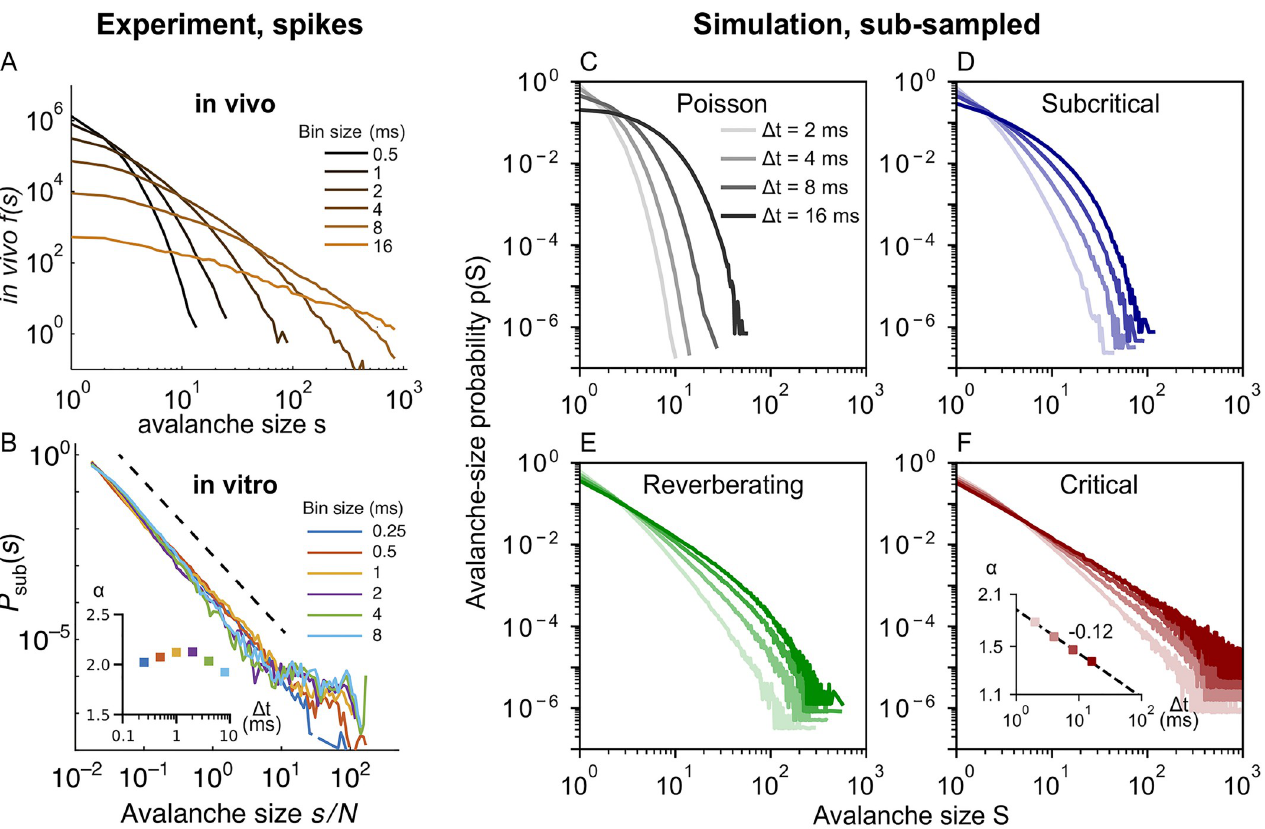
Fig 7. In vivo avalanche-size distributions p ( S ) from spikes depend on time-bin size Δ t . In vivo results from spikes are reproduced by sub-sampled simulations of subcritical to reverberating dynamics . Neither spike experiments nor sub-sampled simulations show the cut-off that is characteristic under coarse-sampling. A : Experimental in vivo results (spikes, awake monkey) from an array of 16 electrodes, adapted from [24]. The pronounced decay and the dependence on bin size indicate subcritical dynamics. B : Experimental in vitro results (spikes, culture DIV 34) from an array with 59 electrodes, adapted from [44]. Avalanche-size distributions are largely independent of time-bin size and resemble a power law over four orders of magnitude. In combination, this indicates a separation of timescales and critical dynamics (or even super critical dynamics [45]). B, Inset : Log-Lin plot of fitted α , fit range s / N � 5. C–F : Simulation for sub-sampling, analogous to Fig 6. Subcritical dynamics do not produce power-law distributions and are clearly distinguishable from critical dynamics. F : Only the (close-to) critical simulation produces power-law distributions. F, Inset : Log-Log plot of fitted α , fit range S � 50. In contrast to the in vitro culture (in B), the simulation does not feature a separation of time scales (due to external drive and stationary activity), and therefore the slope shows a systematic bin-size dependence here.